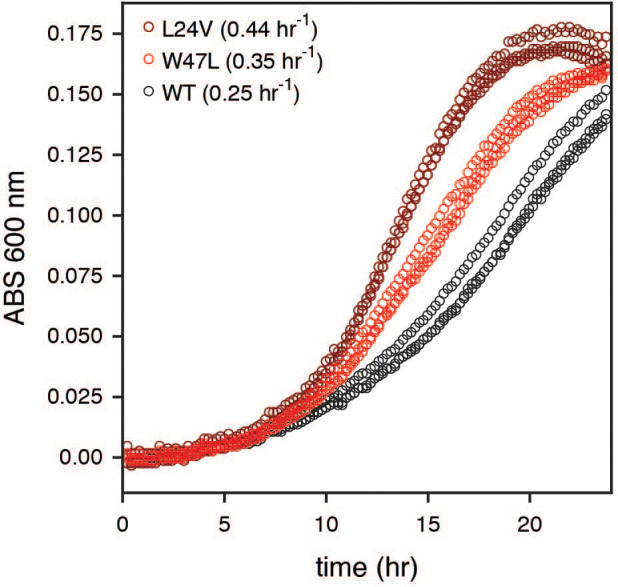
Growth curves for top advantageous mutations.The absorbance (ABS) at 600 nm was monitored in 96-well plate format for monocultures of the selection strain transformed with strong advantageous mutants (L24V in dark red, W47L in bright red, wild-type in black). The doubling rates (top left in plot) were calculated from the early exponential phase of growth (see Methods). All growth curves are shown as sets of three biological replicates.